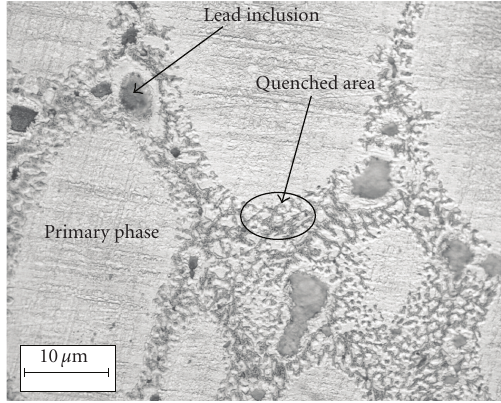
Figure 4: Microstructure of Cu-5Sn-5Pb alloy quenched from monotectic